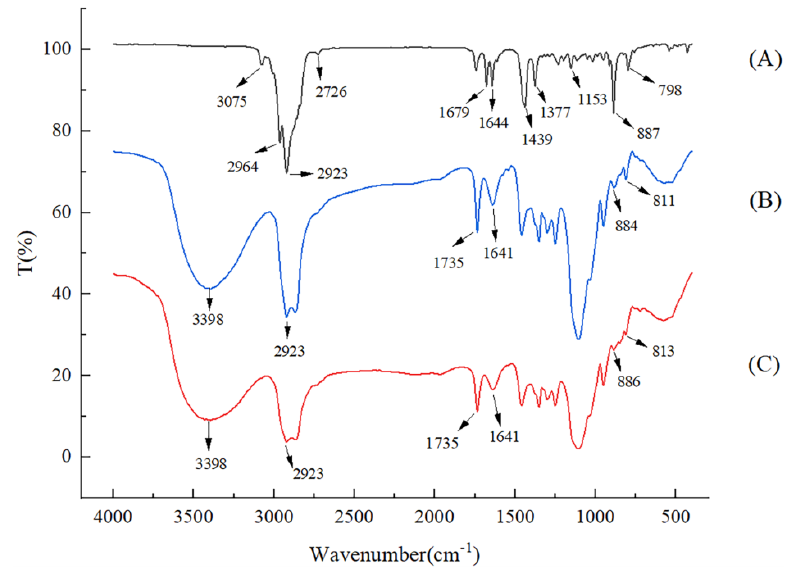
Figure 1. Infrared spectrum of freeze − dried samples of LEO ( A ), KGOS ( B ), and LEO/NE ( C ). The spectrum of KGOS shows that the absorption band at 3398 cm − 1 is assigned to the stretching of methyl -OH, [23] the stretching peak at 2923 cm − 1 is assigned to methyl-CH, and the peak at 1735 cm − 1 is assigned to the stretching of acetyl and octenyl succinic anhydride carbonyl (C=O). [26] The absorption peaks at 811 and 884 cm − 1 correspond to the stretching vibrations of the mannose unit [37]. The above peaks can be observed in the spectrum of LEO/NE. Some main peaks (3075, 2964, 2858, 1679, 1153 cm − 1 ) in LEO were invisible or significantly weakened in the spectrum of LEO/NE, and some peaks (2923, 1644, 1439, 1377, 887, 798 cm − 1 ) were slightly weaker in LEO/NE (Figure 1C). Compared with KGOS, LEO/NE had no new observed peaks, which indicated that LEO and KGOS were connected to each other inside the molecules without chemical interaction. These phenomena indicate that LEO is embedded in the nanoemulsion and present in LEO/NE with little or no free molecular